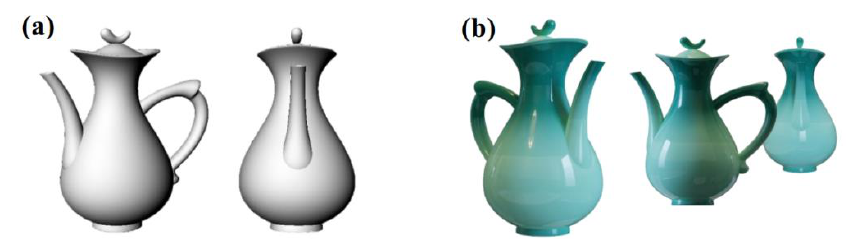
Figure 7. Elegant imagery design scheme: ( a ) elegant imaginary wine jug model; ( b ) effect of wine jug model.